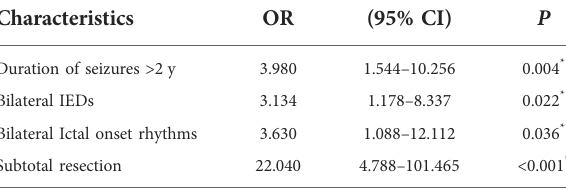
TABLE 2 The potential prognostic factors associated with seizure outcomes on multivariate analysis.